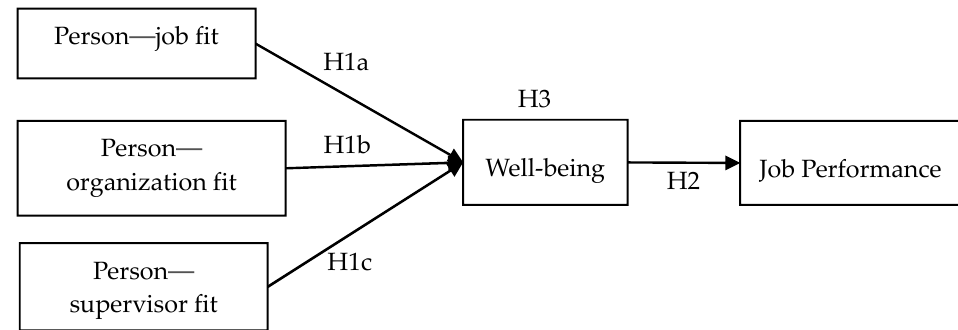
Figure 1. The framework of person–environment polychronicity, well-being, and job performance .